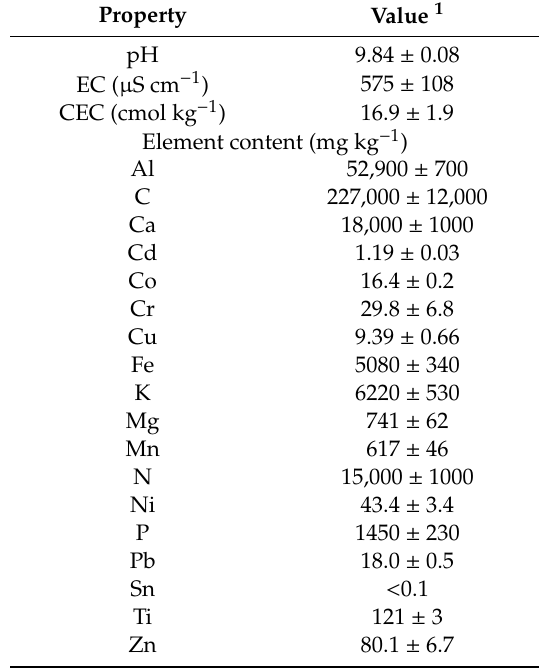
Table 1. Properties of the jatropha fallen leaf biochar produced in this study.